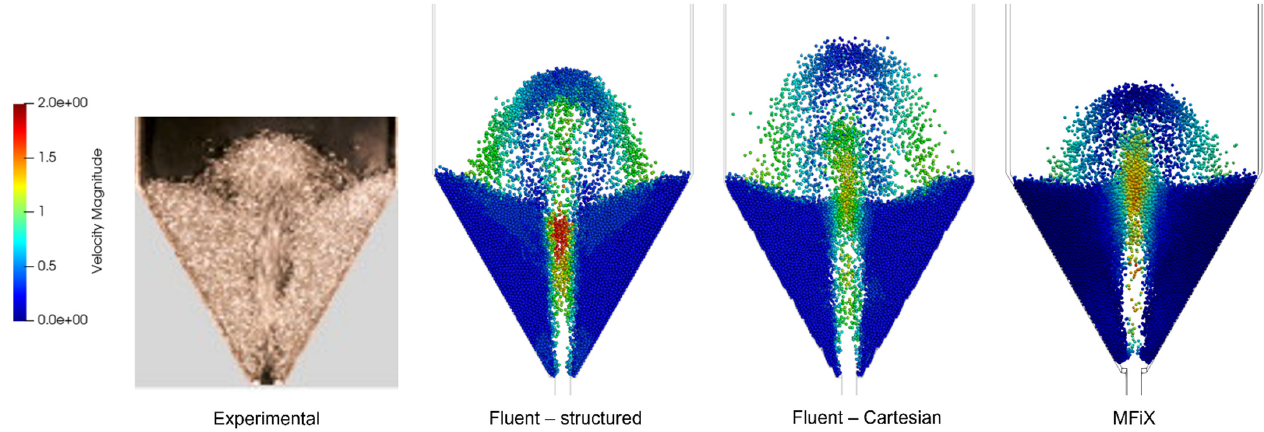
Figure 2. Configuration of the particles after 2 s of simulation with the Gidaspow drag model. The particles are coloured according to their velocity magnitude. Experimental snapshot reprinted from [14], Copyright (2008), with permission from Elsevier.